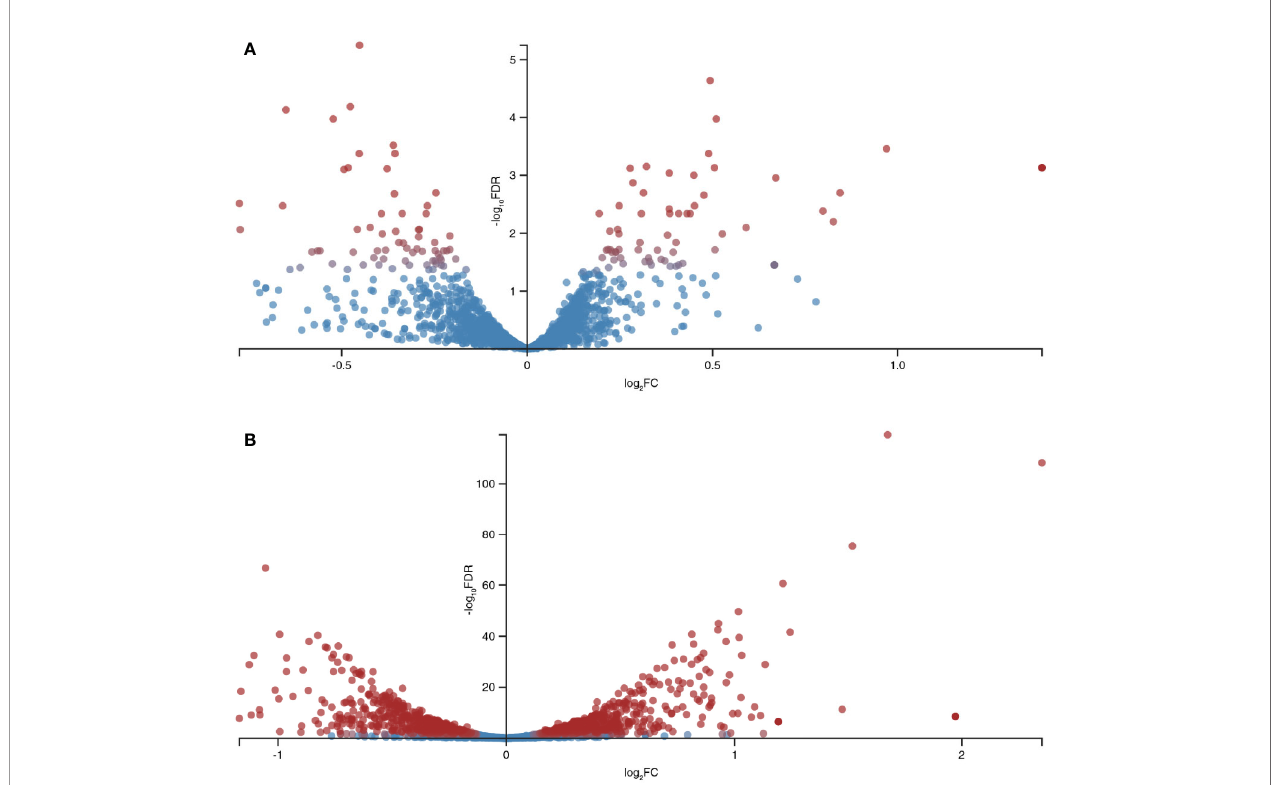
FIGURE 2 | Global differentially expressed genes (DEGs) in B. longum subsp. longum GT15 resulting from (A) exposure to IL-6, (B) exposure to TNF a . Red dots: DEGs; blue dots: not